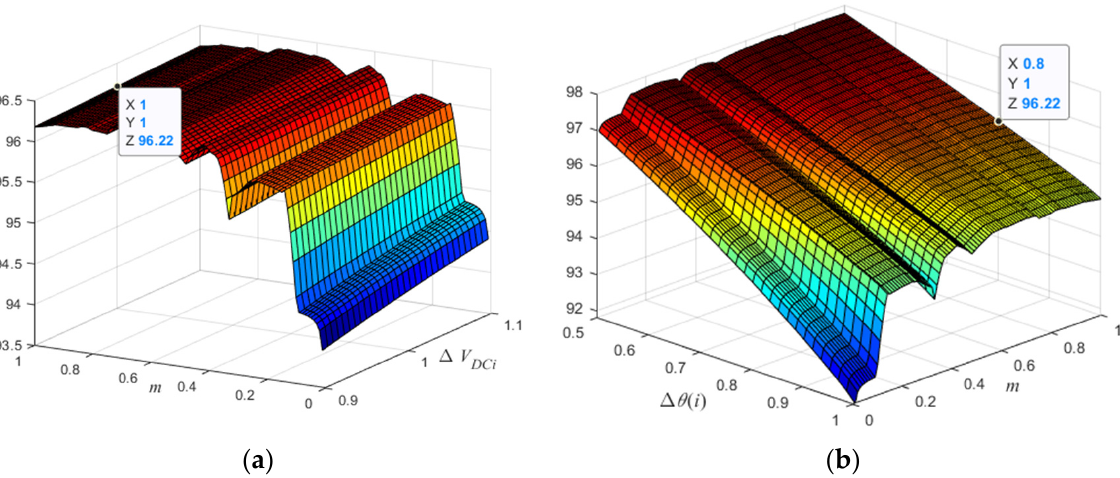
Figure 11. Efficiency analysis in the event of disturbances. ( a ) V DCi variation v/s m , ( b ) θ (i) variation v/s m .